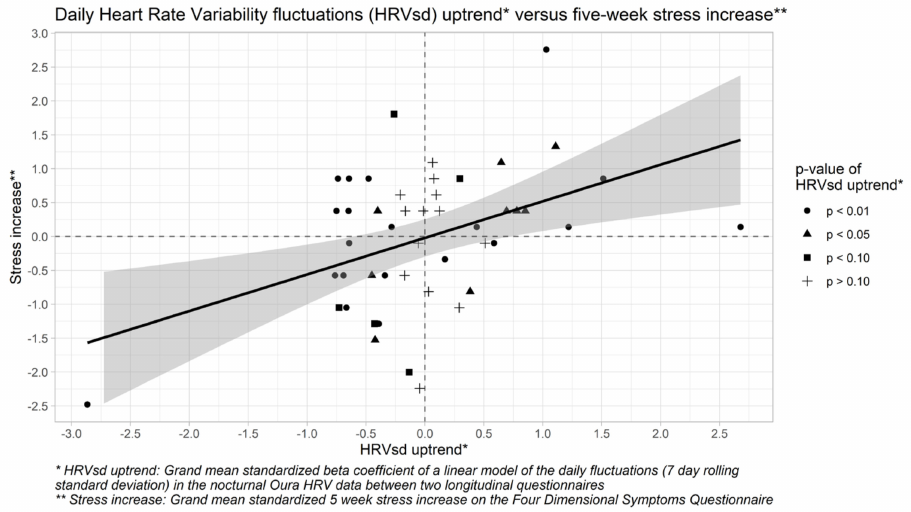
Figure 1. Scatter plot for the five-week uptrends in the 7-day rolling standard deviation of the Heart Rate Variability (HRVsd) versus five-week stress increases on the Four-Dimensional Symptom Questionnaire (4DSQ) in all 47 observations of the 9 participants in this study. The grey area represents the 95% confidence interval for the values that are estimated by the linear model (the thick black